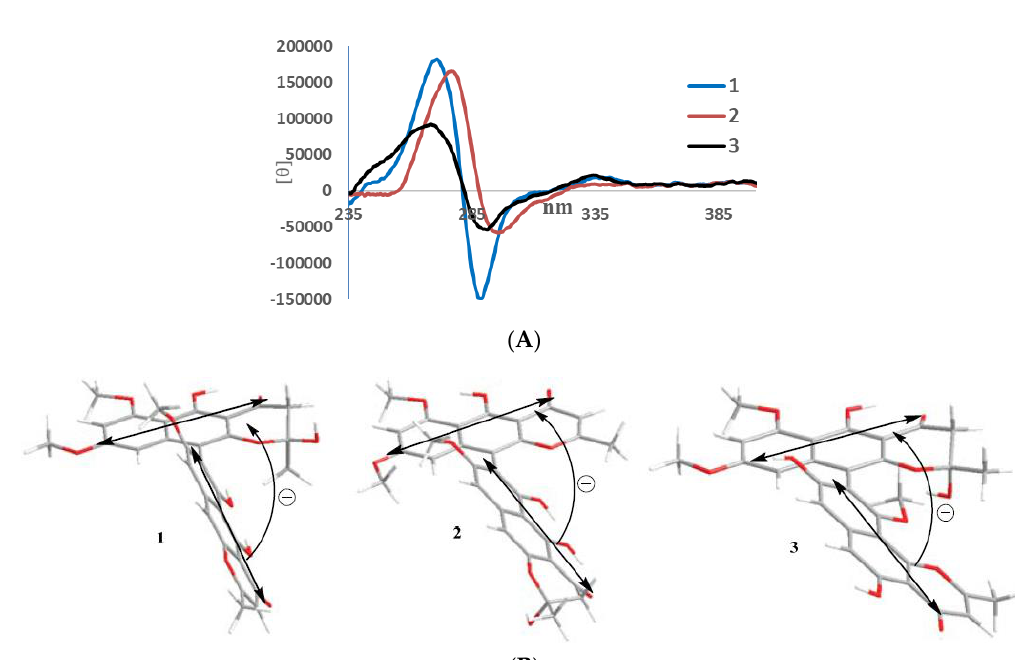
Figure 3. ECD spectra ( A ) and negative exciton chirality ( B ) of teratopyrones A–C ( 1 – 3 ).